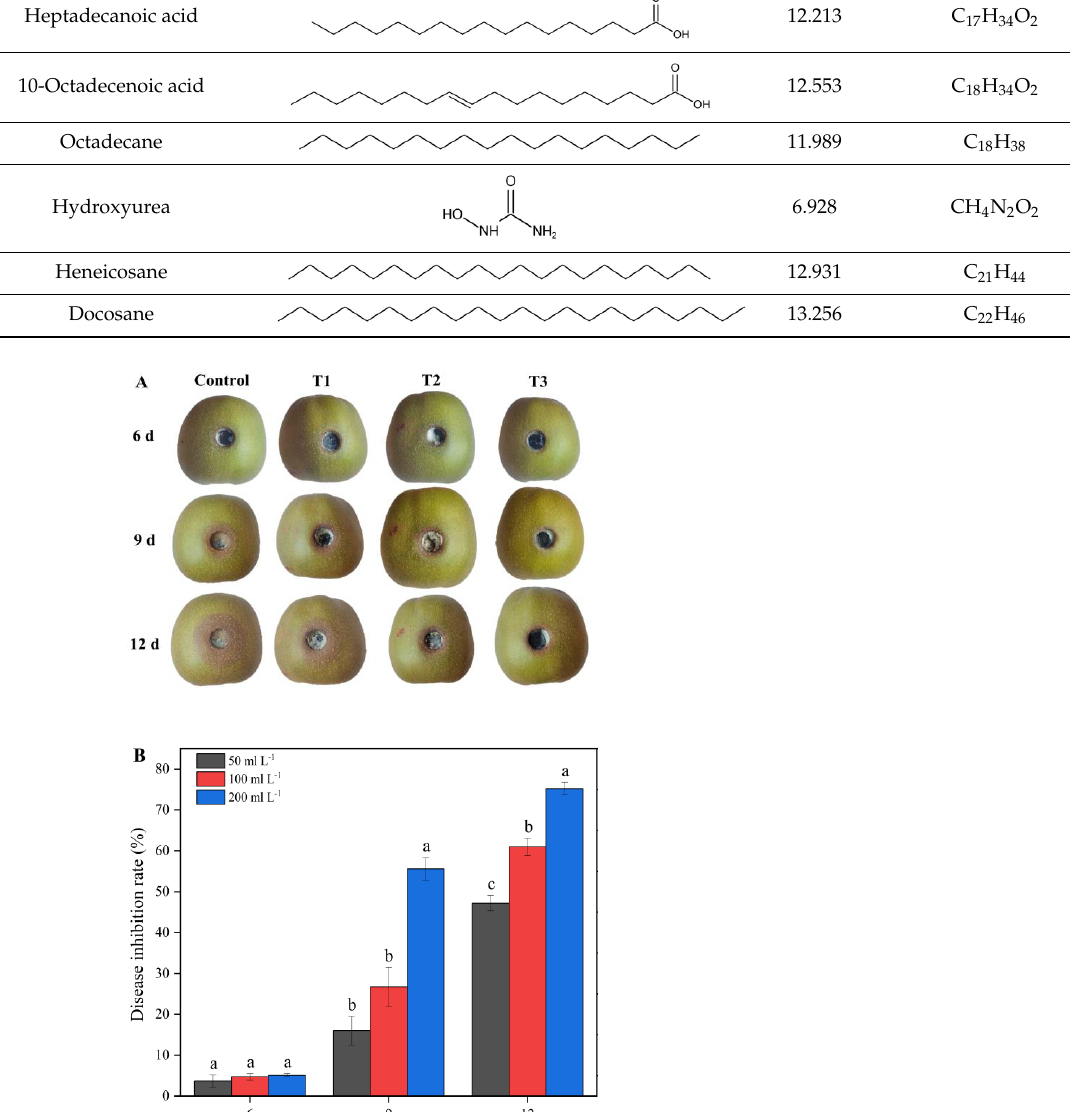
Figure 12. In vivo effect of aseptic filtrate on disease extension in kiwifruit caused by A. alternata . ( A ) Disease extension symptom in kiwifruit after treatment with 50 mL L −1 (T1), 100 mL L −1 (T2), and 200 mL L −1 (T3) aseptic filtrate for 6, 9, and 12 d. ( B ) Disease inhibition rate after treatment with different concentration aseptic filtrates. Data are displayed as the mean ± SE. Bars with the same lowercase letters indicate no significant difference between treatments ( p < 0.05).